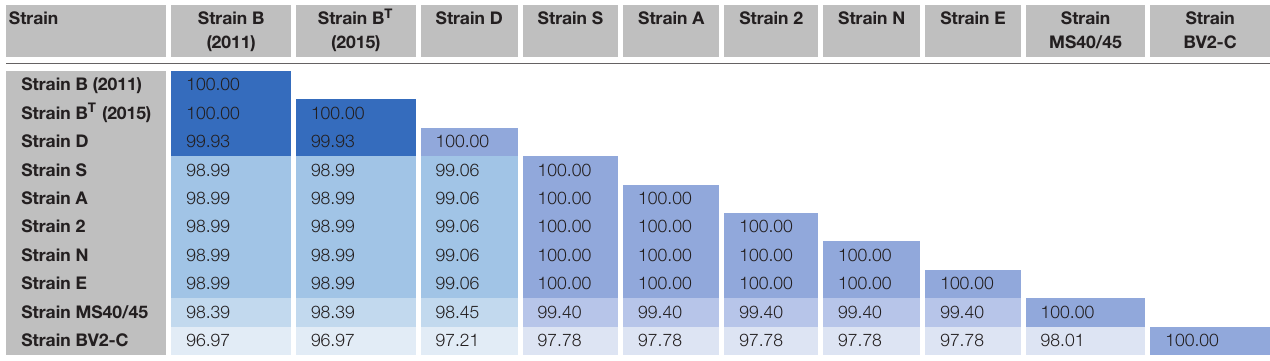
TABLE 2 | Pairwise percent similarity values for 16S rRNA sequences of strains of Chloracidobacterium spp. Strain Strain B Strain B T Strain D Strain S Strain (2011)